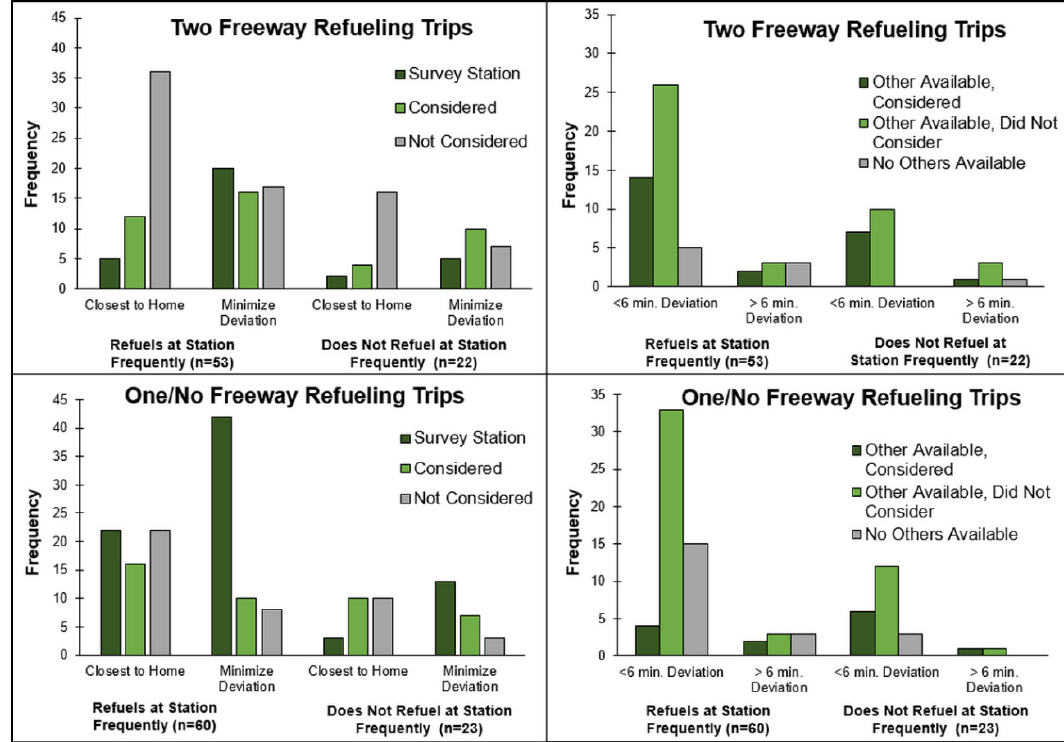
Figure 5. Rank-order preference ( left ) and deviation threshold proximity ( right ) of the refueling station and other considered stations by freeway refueling trip type and refueling frequency.